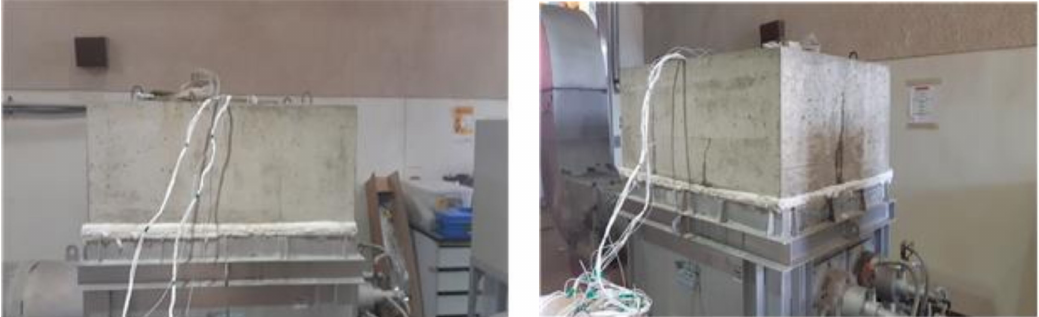
Figure 5. Experimental setup for the fire exposure test using the RABT fire